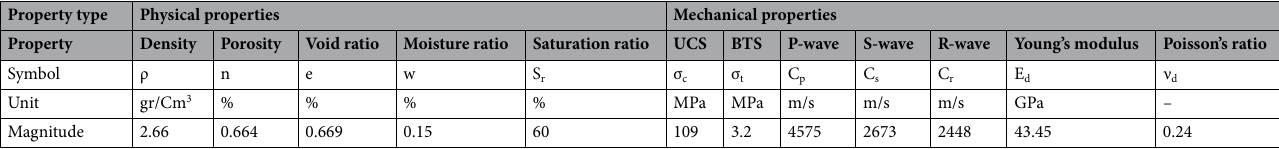
Table 1. Physical and mechanical properties of the tested mudstone in this